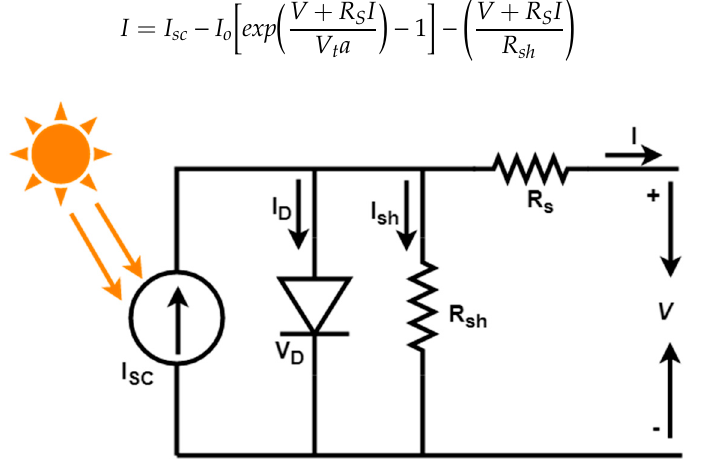
Figure 1. Equivalent single diode electrical model of a solar cell.